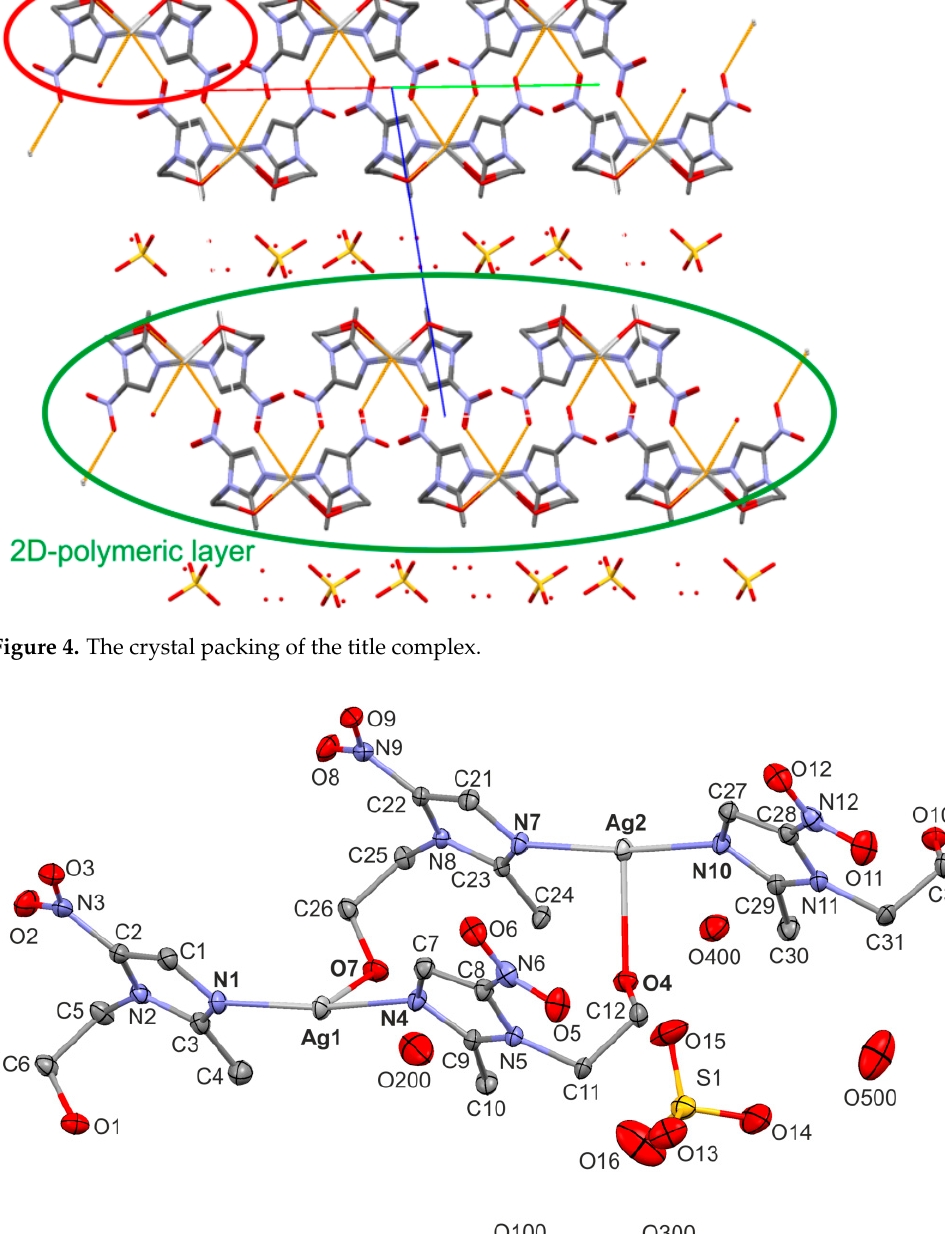
ellipsoids are drawn at a 50% probability level. Hydrogen atoms are omitted for clarity.